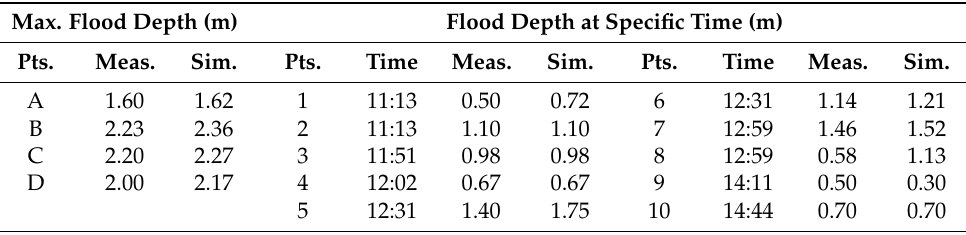
Table 2. Comparison of observations and simulations at the points shown in Figure 8.